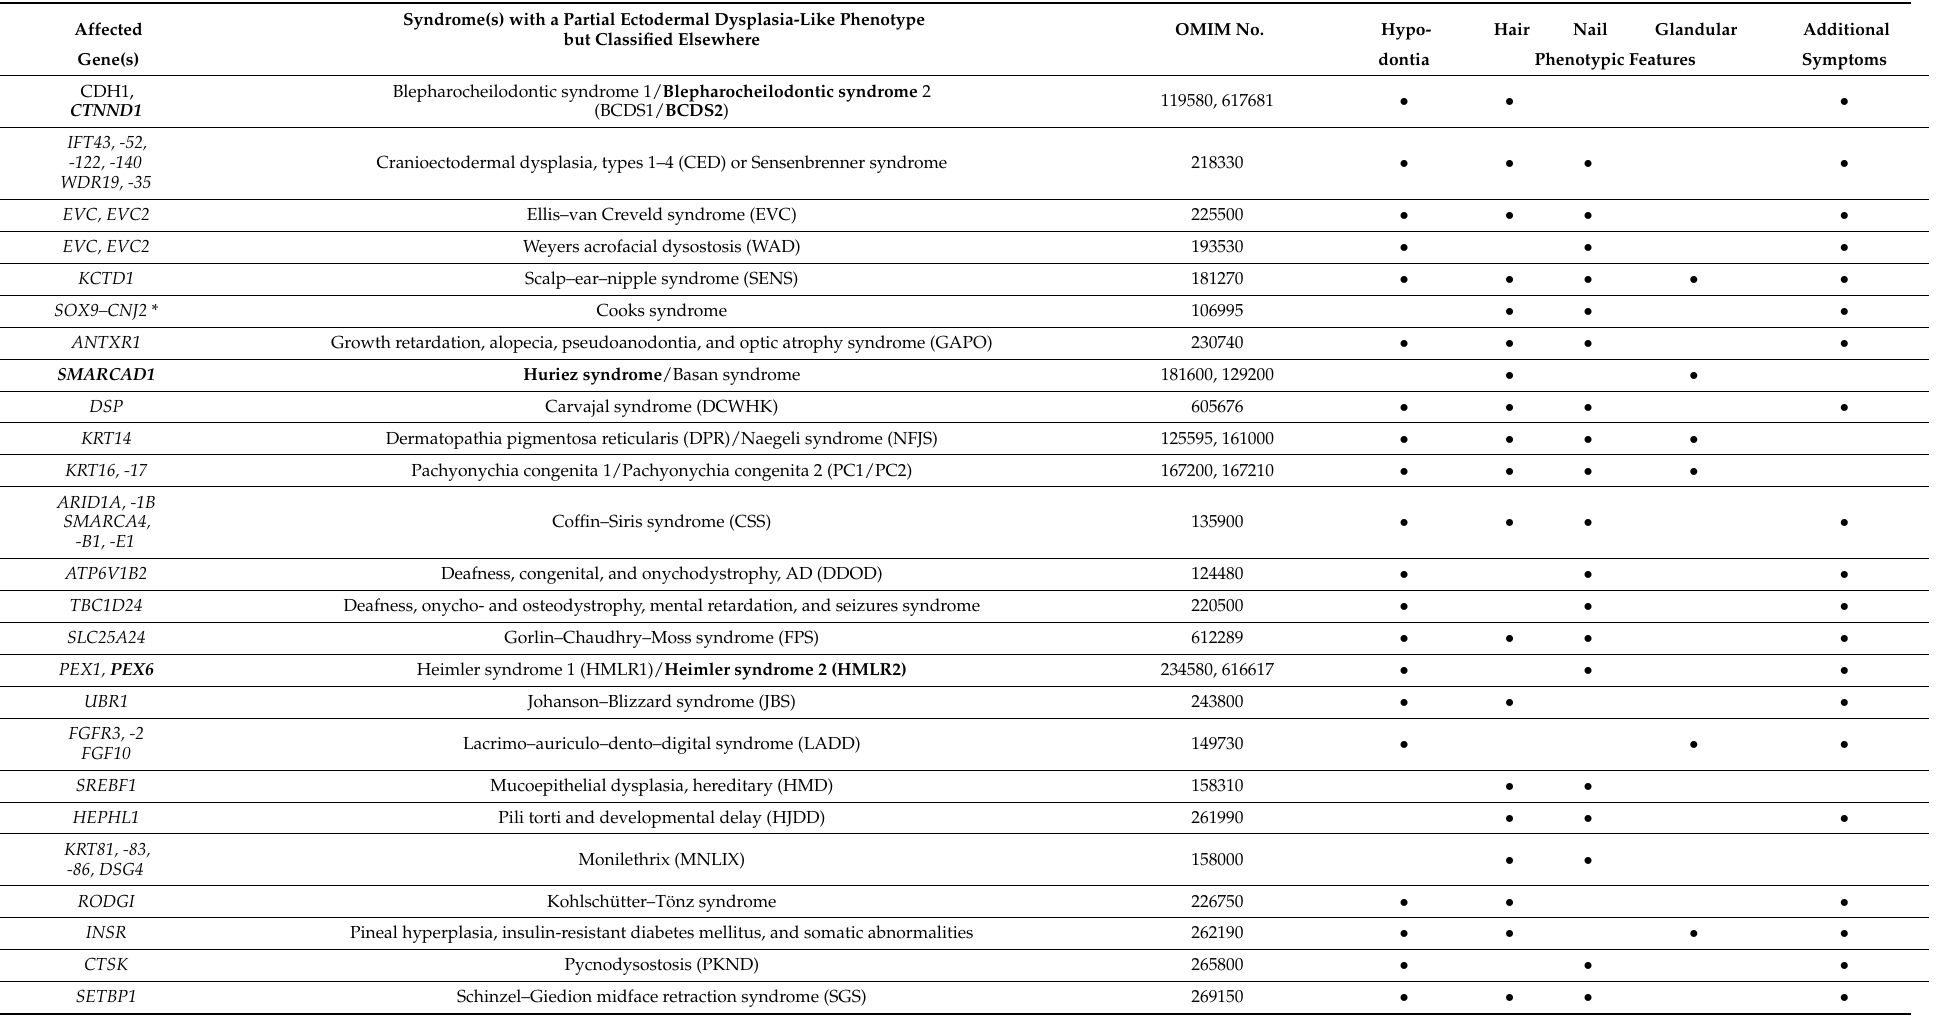
Table 2. Syndromes with features of ED that are related to genes apparently not involved in the already known pathways and that mainly affect organs of non-ectodermal origin or where ED is just a small part of a complex syndrome. Only syndromes included in the previous classification of ectodermal dysplasias [3] were listed. Most of them could be classified elsewhere (bold, newly added disease entities). * The genetic abnormality is a duplication in the putative regulatory region (not the promoter) of SOX9 (located between the SOX9 and KCNJ2